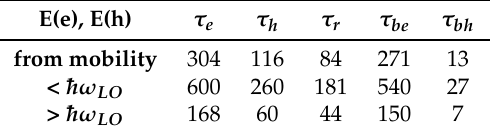
Table 1. Electron and hole relaxation times [fs] in GaAs at 300 K. The τ r , τ be and τ bh columns were obtained from Equations (9) and (11) and used in Equations (2) and